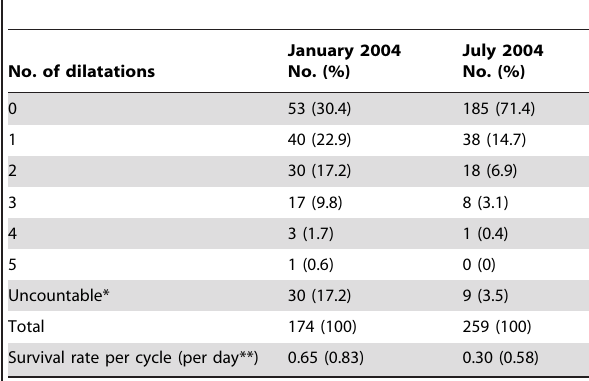
Table 6. Number of dilatations in collections of Anopheles darlingi collected in January and July,